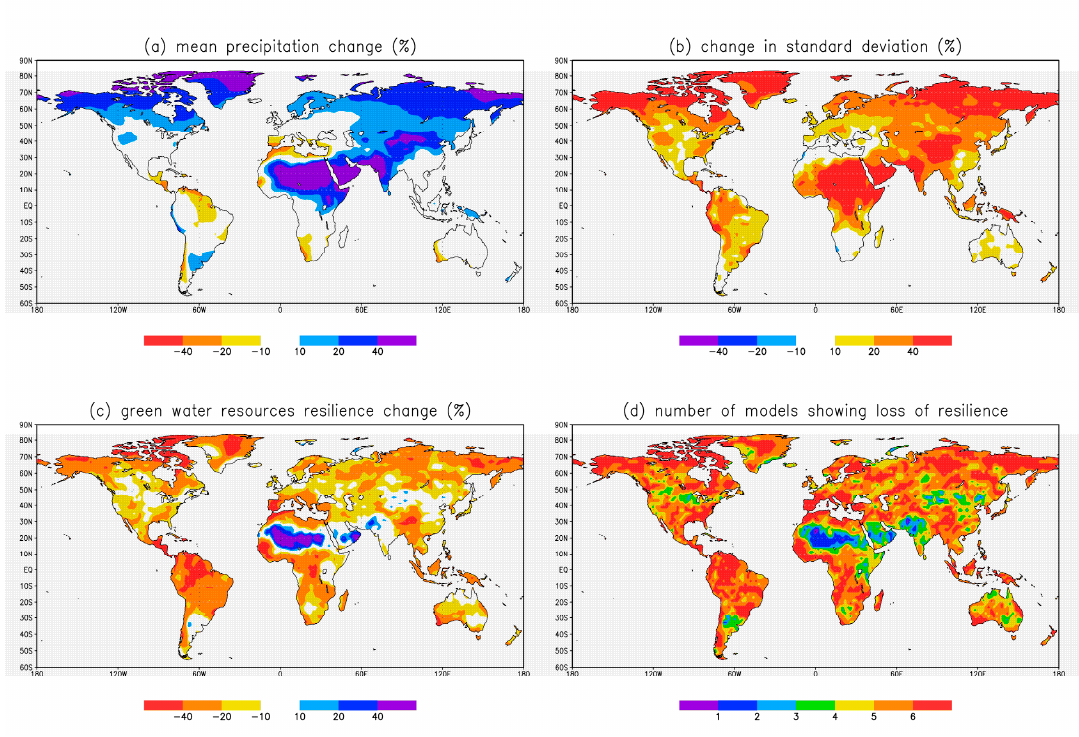
Figure 5. Analysis of annual mean precipitation data simulated by 6 climate models for the historical period 1851–2014 and for the future scenario SSP585 over the period 2015–2100: ( a ) Percent mean precipitation change; ( b ) change in standard deviation; ( c ) change of annual green water resources Resilience indicator ( R P ); ( d ) number of models projecting reduction of Green Water Resources (GWR) resilience.